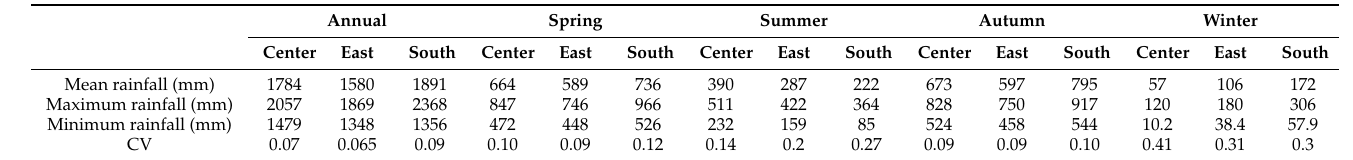
Figure 1. Regional map of Cameroon. The numbers at the top in each region indicate the area in km 2 , and those below indicate the percentage (%) of occupation of this region in the national territory (Cameroon). Table 1. Statistical properties of annual and seasonal rainfall for the southern regions of the country (Center, East, and South). Each of these regions has 4